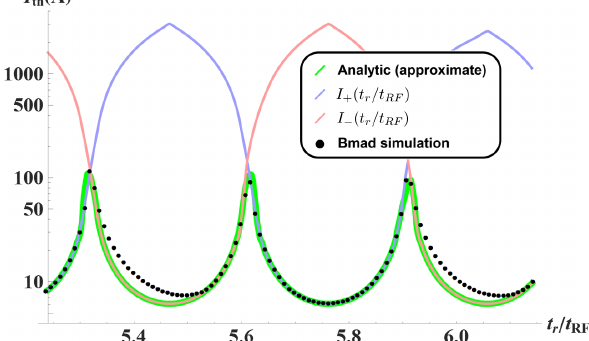
FIG. 18. Comparison of the I obtained from the approximate th analytic formula [Eq. (19)] and BMAD simulation for case D1. The two candidates for I [ I (cid:1) from Eq. (20)] are also plotted. th